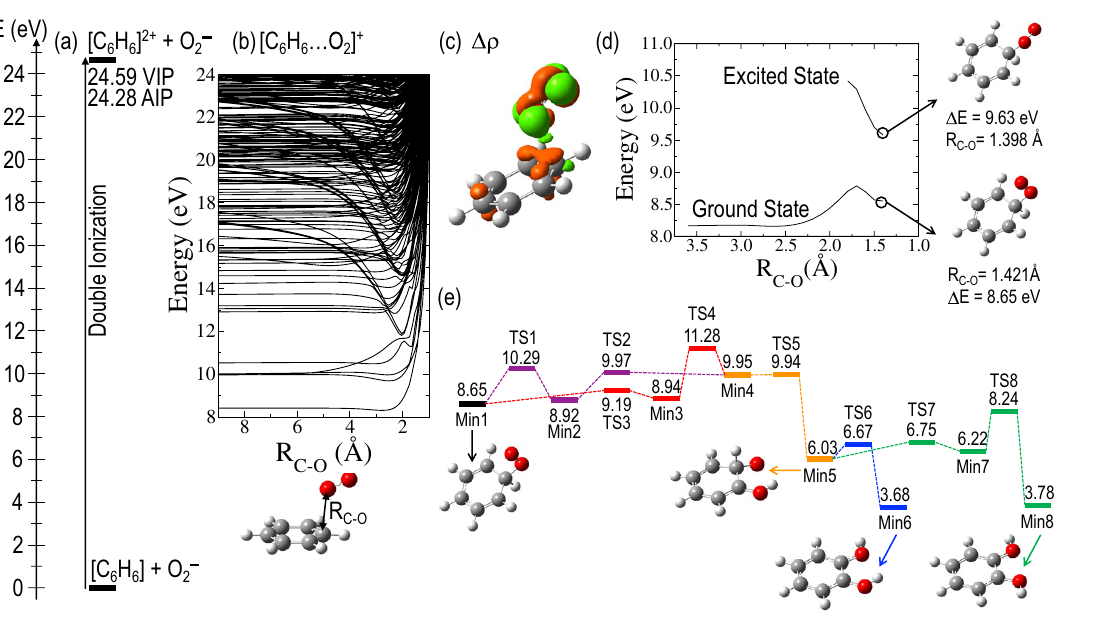
Figure 4. ( a ) 1st + 2nd Ionization energy of benzene, C 6 H 6 , keeping the geometry of the neutral (vertical ionization potential—VIP), and after geometry optimization of the doubly-ionized (adiabatic ionization potential—AIP). ( b ) Potential energy curves as a function of the benzene–oxygen distance for the [C 6 H 6 … O 2 ] + system in a frozen scan. ( c ) Distribution of the electronic density difference (∆ ρ with an isovalue of 0.007) between the ground and the lowest energy excited state with charge transfer character C 6 H 6 2+ –O 2 , for R C-O ≈ 2 Å. Red and green lobes correspond to loss and gain of electron density, respectively. ( d ) Potential energy curves as a function of the C-O distance in a relaxed scan both in the ground and in the excited states with charge transfer character. ( e ) Critical points in the potential energy surface of C 6 H 6 O 2 + ground state with doublet spin multiplicity. Min indicates a minimum, TS indicates a transition state. Relative energies are given in eV and have been corrected with the zero-point-energy (ZPE). See rest of the structures in the Supplementary Information. In all panels relative energies are given in eV and refereed to the ground state of C 6 H 6 and O 2 − at infinite